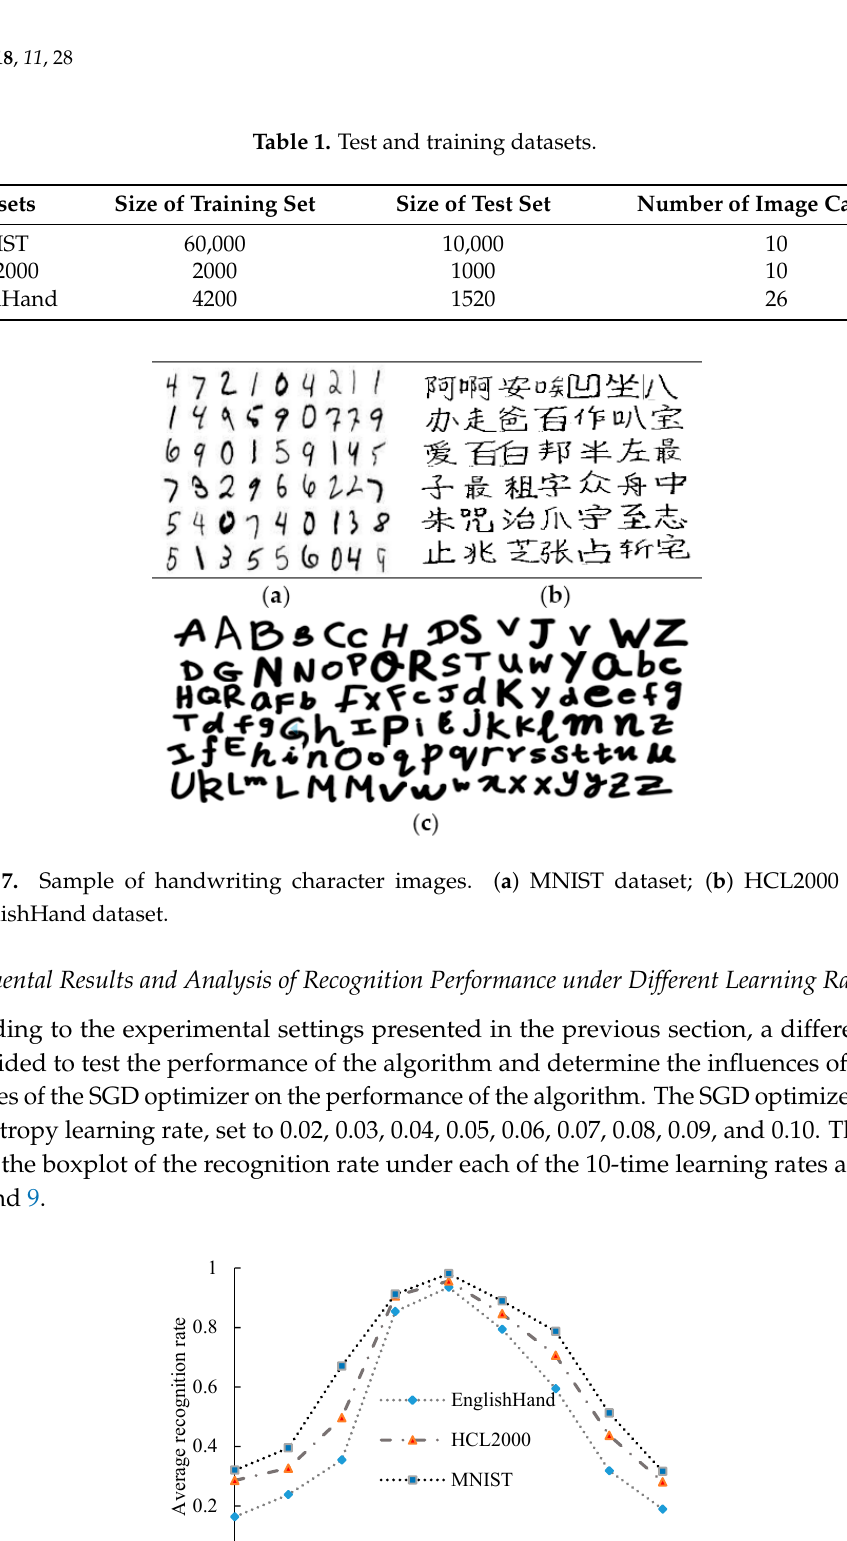
( a ) ( b ) ( c ) Figure 9. Boxplot of the recognition rate obtained by MCNN-DS under different SGD learning rates. ( a ) MNIST dataset; ( b ) EnglishHand dataset; ( c ) HCL2000 dataset. For the three datasets tested, the recognition rate of the model increases with the learning rate and the learning and recognition rates show a positive correlation when learning is in the [0.02, 0.05] range (Figure 8). When the learning rate distribution of the SGD optimizer is 0.05–0.07, the recognition rate of the model is in a relatively stable state. At this time, the recognition rate of the